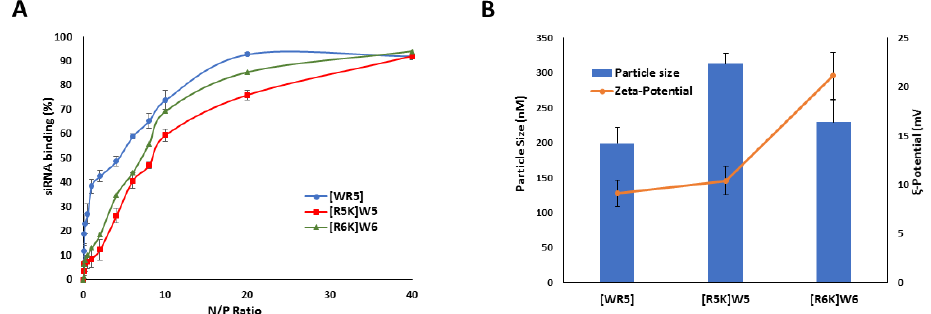
Figure 5. Characterization of peptide interactions with siRNA: ( A ) The binding affinity was determined at different N/P ratios to determine the N/P ratio required for 50% binding (BR50), using SYBR Green II exclusion assay ( n = 3). Among the selected peptides, [WR] 5 showed the highest binding affinity to siRNA; ( B ) Particle size, and surface charge of the particles were determined at an N/P ratio of 20 (Zeta Sizer; n = 3). [R 5 K]W 5 and [R 6 K]W 6 showed the highest particle size and surface charge, respectively, among the peptides included in this study.